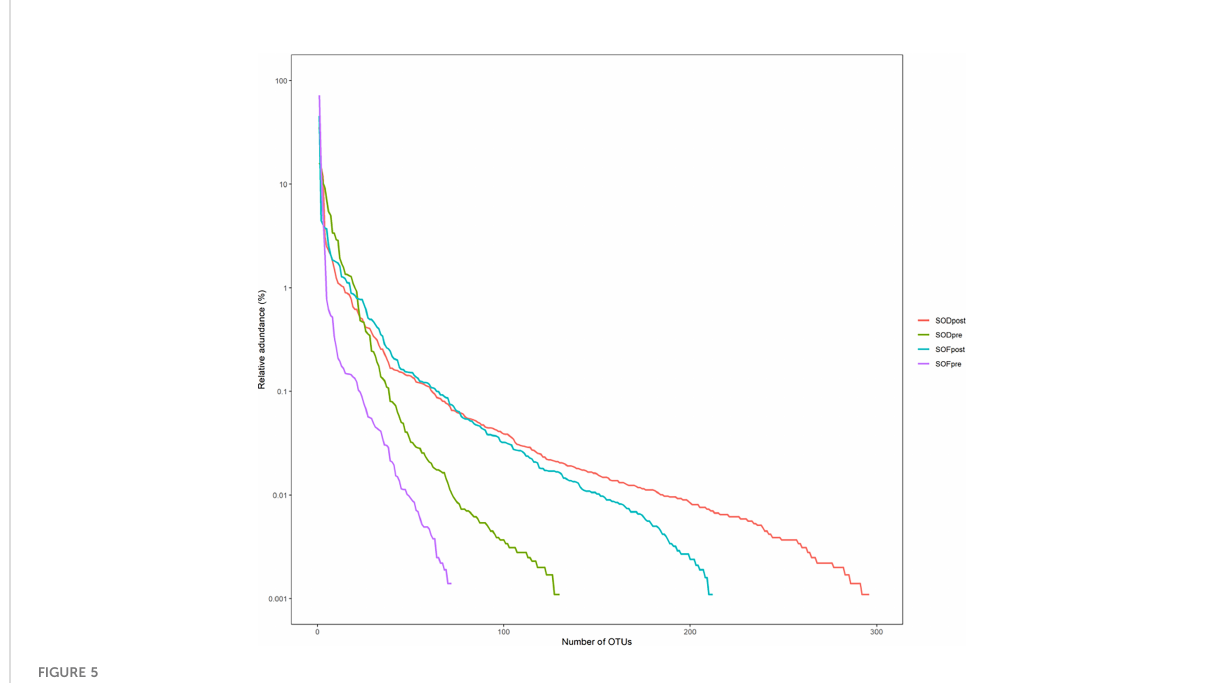
FIGURE 5 Rank abundance curves of